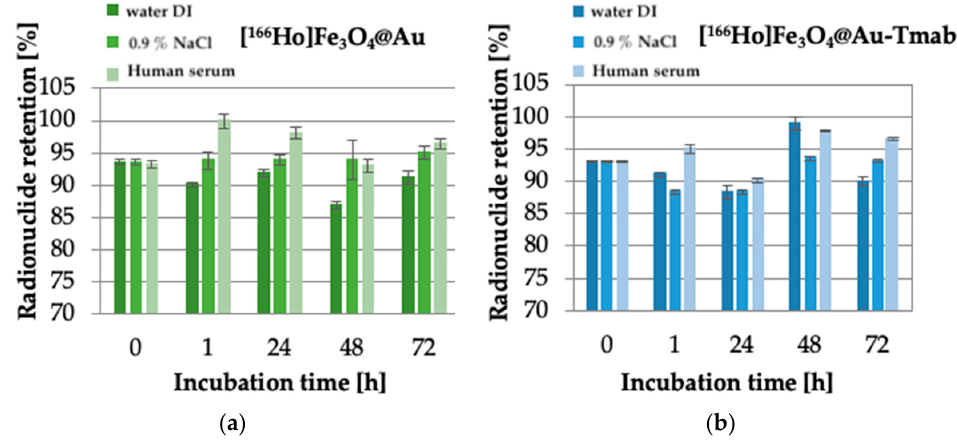
Figure 8. Stability studies of: ( a ) [ 166 Ho]Fe 3 O 4 @Au, ( b ) [ 166 Ho]Fe 3 O 4 @Au-Tmab in water DI, 0.9% NaCl and human serum. Data are expressed as mean ± SD ( n = 3).